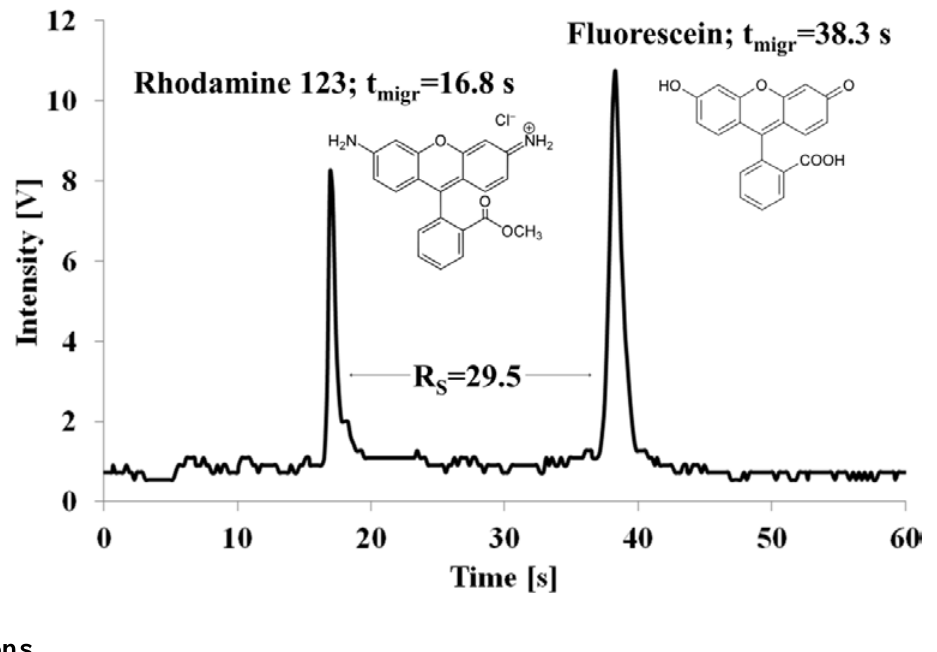
Figure 9. Microchip electrophoresis separation of rhodamine 123 (50 µM) and fluorescein 123 (10 µM) in 40 mM sodium hydroxide at 400 V·cm −1